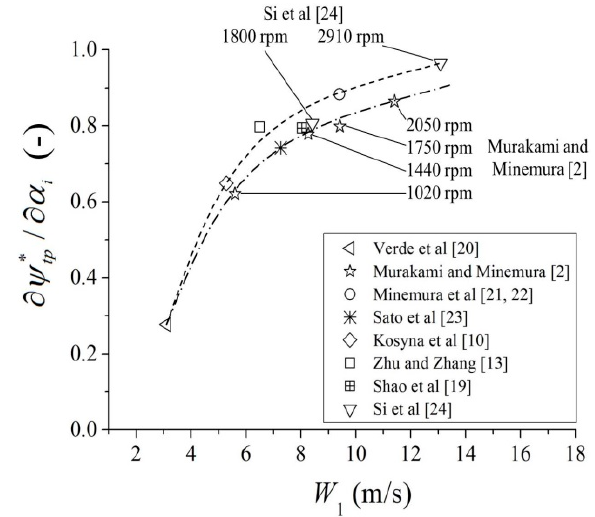
Figure 4. Evolution of ψ * tp negative slope value versus impeller inlet relative velocity.